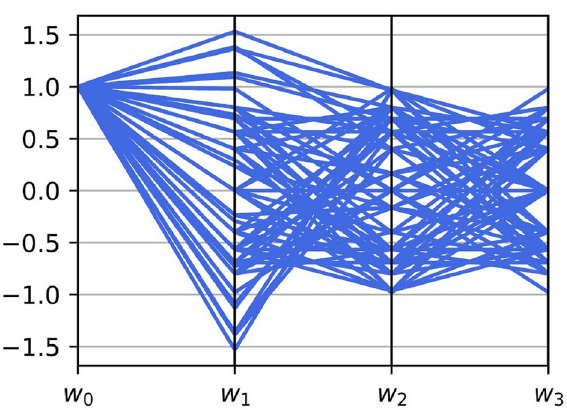
˜ p 2 N = 1 on parallel n n = 1 (cid:31)